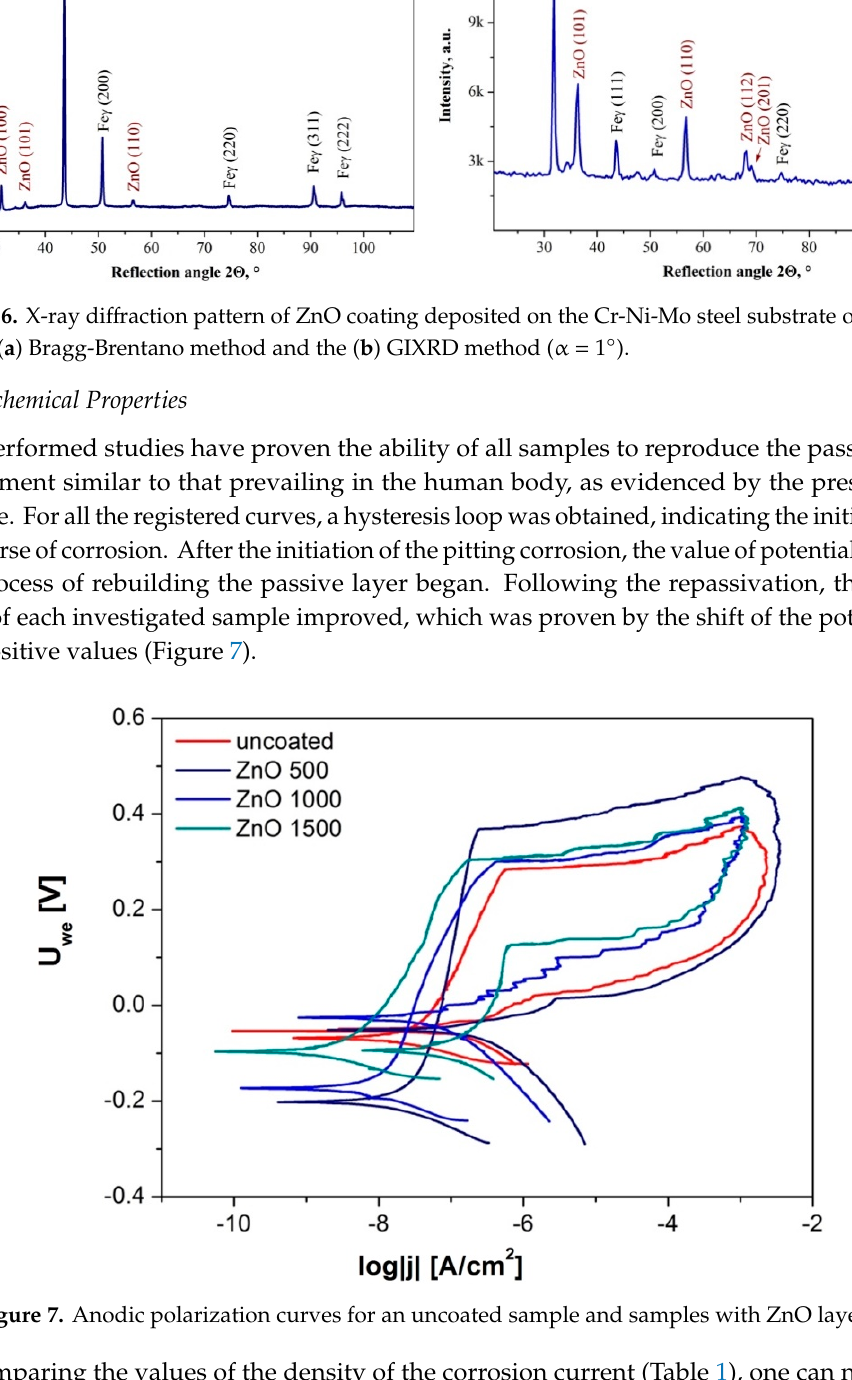
Figure 7. Anodic polarization curves for an uncoated sample and samples with ZnO layers.